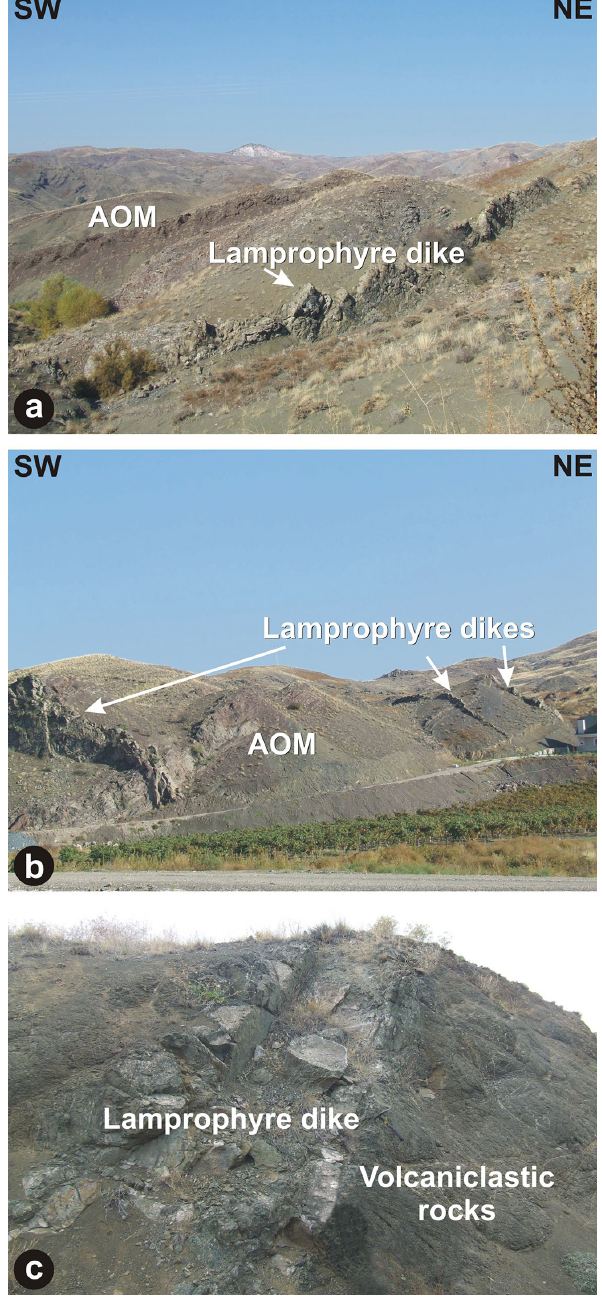
Fig. 11. Lamprophyric dikes crosscutting various lithological units in the Ankara Mélange.